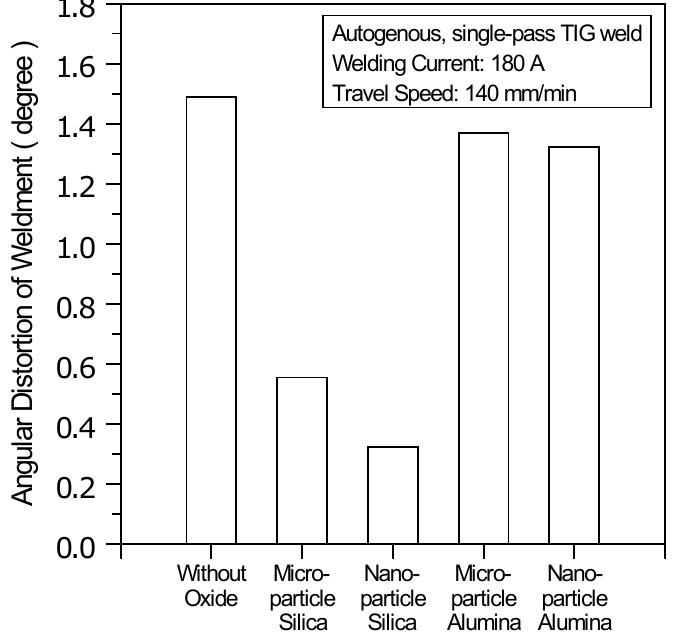
Figure 8. Angular distortion of TIG weldments made with and without